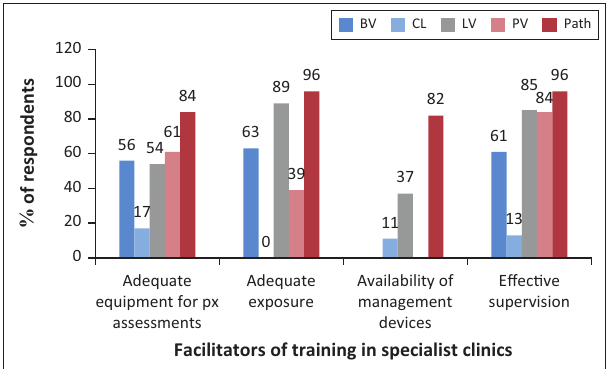
FIGURE 4: Perceptions of the opportunity for the training of specialist skills at decentralised clinical training sites for students. TABLE 1: Perception of clinical training at decentralised clinical training sites and influence on competency from a student perspective (percentage of respondents). Other